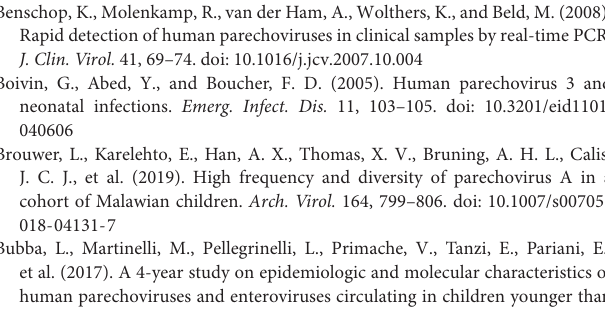
Supplementary Figure 2 | Phylogenetic analysis of all the HPeV1 strains based on the compete VP1 sequence. (A) The whole phylogenetic tree of HPeV1. (B) The detailed phylogenetic tree for Cluster 2. (C) The detailed phylogenetic tree for Cluster 1. The strains of green names with the beginning of “HUXI” were isolated from patients with Group 1 (patients with acute respiratory tract infection). The strains of red names with the beginning of “FX” were isolated from Group 2 (patients with diarrhea). The strains of blue names with the beginning of “HFMD” were isolated from Group 3 (patients with hand-foot-mouth disease). Supplementary Figure 3 | Phylogenetic analysis of all the HPeV3 strains based on the compete VP1 sequence. (A) The whole phylogenetic tree of HPeV3. (B) The detailed phylogenetic tree for Cluster 1. (C) The detailed phylogenetic tree for Cluster 2. The strains of green names with the beginning of “HUXI” were isolated from patients with Group 1 (patients with acute respiratory tract infection). The strains of red names with the beginning of “FX” were isolated from Group 2 (patients with diarrhea). The strains of blue names with the beginning of “HFMD” were isolated from Group 3 (patients with hand-foot-mouth disease). Supplementary Figure 4 | The temporal pattern of HPeV infection. (A) The relation between year and HPeV genotypes among all pediatric patients. (B) Annual patterns of detected HPeV. (C) The relation between season and HPeV detection rate among three groups of pediatric patients. Group 1: patients with acute respiratory tract infection (ARTI), Group 2: patients with acute diarrhea, Group 3: patients with hand, foot and mouth disease (HFMD). Supplementary Figure 5 | The temporal pattern of HPeV1, HPeV3, and HPeV4 infection. (A) Annual patterns of HPeV1. (B) The relation between year and HPeV1 genotypes among all pediatric patients. (C) Annual patterns of detected HPeV3. (D) The relation between year and HPeV3 genotypes among all pediatric patients. (E) Annual patterns of detected HPeV4. (F) The relation between year and HPeV4 genotypes among all pediatric patients. Group 1: patients with acute respiratory tract infection (ARTI), Group 2: patients with acute diarrhea, Group 3: patients with hand, foot and mouth disease